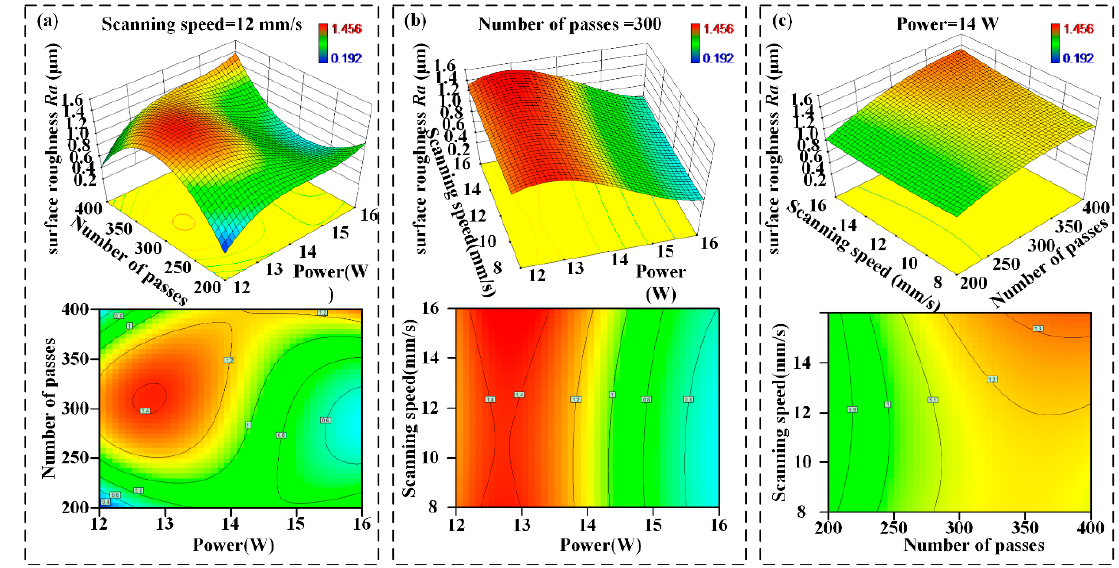
Figure 12. Variations of the Ra with different laser process parameters: ( a ) effects of number of passes and power; ( b ) effects of scanning speed and power; ( c ) effects of scanning speed and number of passes.